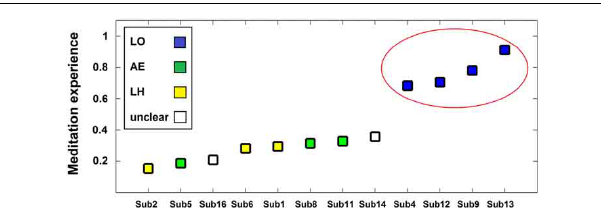
FIGURE 6 | Phenomenological categories and meditative expertise chart. Participants ( x -axis) are plotted as a function of meditative expertise ( y -axis) from least to most -experienced. The meditation experience measure is a normalized (0–1) measure incorporating both years and hours of meditation practice. Colors indicate phenomenological category of participants’ SL description (blue = LO [Lack-of-ownership], green = AE [Altered-experience], yellow = LH [Less-happening], white = unclear). Note the increase in meditative expertise for the LO group (circled in red).